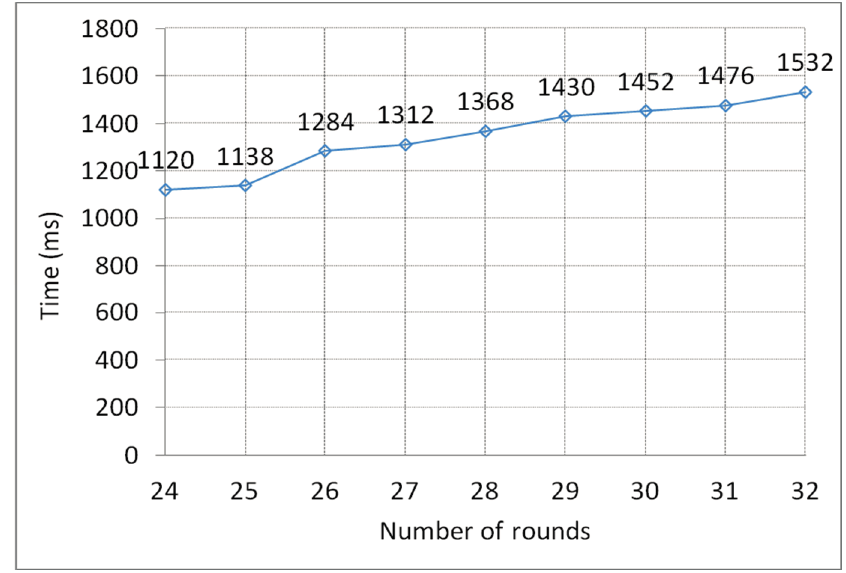
Figure 7. Experimental results of the performance test on Intel